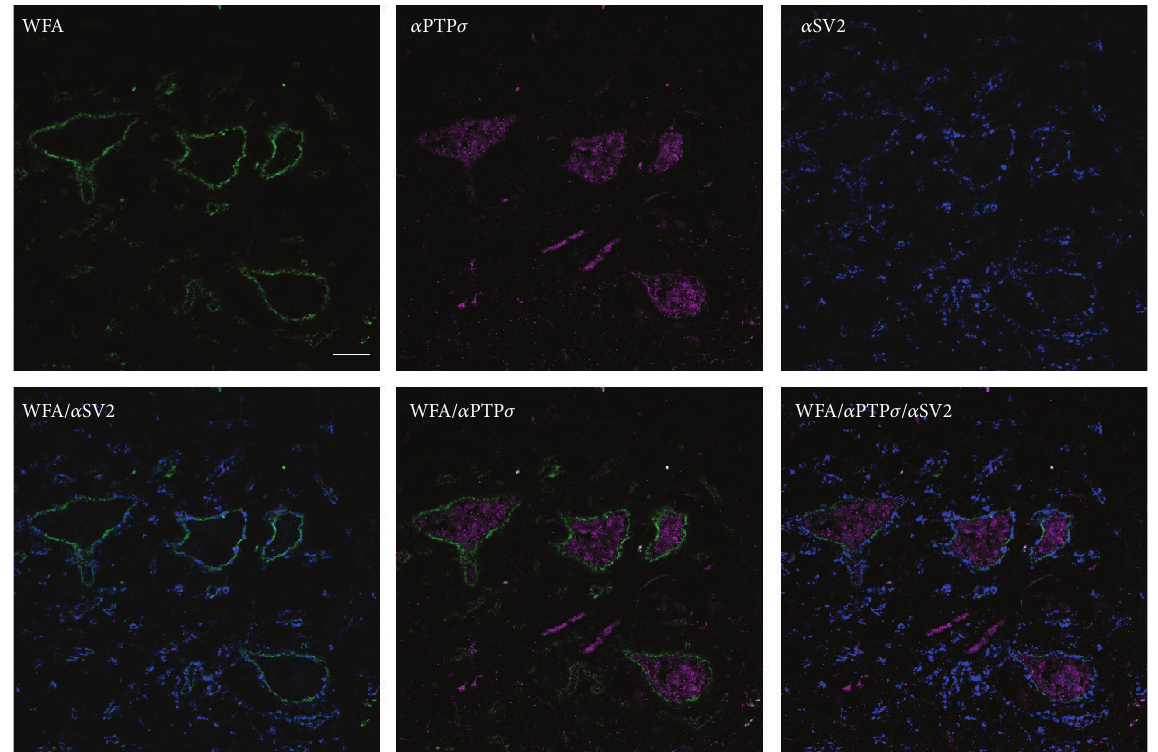
Figure 10: PTP 𝜎 does not colocalize with PNNs or synapses. Expression of PNNs (stained with WFA, green), PTP 𝜎 (pink), and synapses (stained with anti-SV2 antibody, blue) do not overlap. Scale bar = 40 𝜇